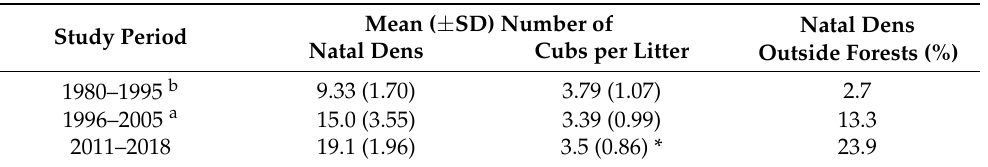
Table 2. The number of natal dens recorded annually and breeding parameters of the red fox in the study area (field and forest mosaic, Central Poland) in the three periods: 1980–1995, 1996–2005 [18], 2011–2018 (this study). b—before rabies vaccination; a—after rabies vaccination; * litter size assessment was performed from 2011 to 2017. Mean ( ± SD) Number Study Period